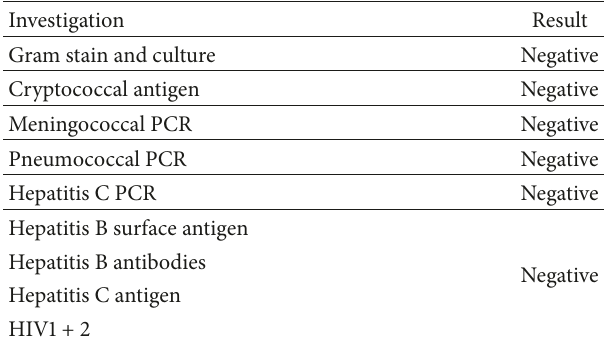
Table 3: Tests of peripheral